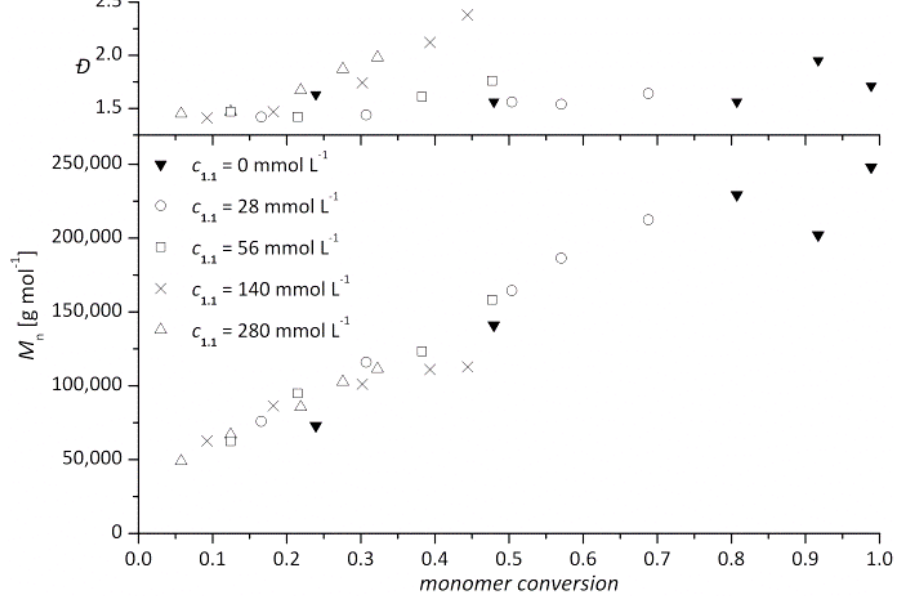
parent structure of the monomers 1.1 and NIPAm, i.e. , acrylate vs. acrylamide. Figure 7. Evolution of the number average molecular weight, M the monomer conversion for a homopolymerization of NIPAm (full symbols) and various copolymerizations of NIPAm and 1.1 using 0.6 mmol·L − 1 R DMF at 60 °C.